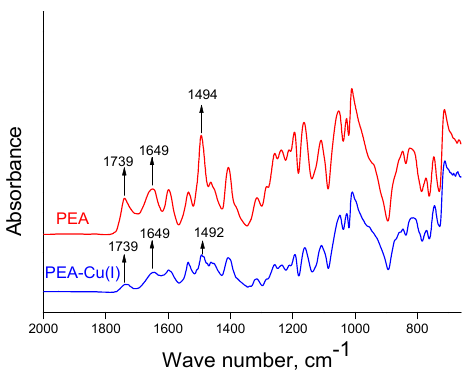
Figure 3. ATR-FTIR spectra of PEA and PEA–Cu(I) membranes.